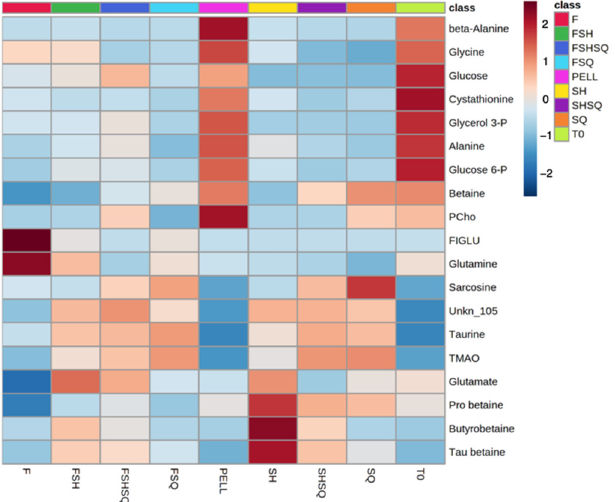
Figure 3. Heat map showing relative metabolite levels for the 19 most discriminating metabolites among the 8 diets (F, FSH, FSHSQ, FSQ, PELL, SH, SHSQ, SQ) and the conditioning diet (T0) measured in red drum liver extracts. A gradient color scale from red (high) to blue (low) indicates mean relative levels of the 19 most discriminating metabolites (rows) in the 9 diets (columns). F, fish diet; FSH, fish + shrimp diet; FSHSQ, fish + shrimp + squid diet; FSQ, fish + squid diet; PELL, pelleted commercial fishmeal-based diet; SH, shrimp diet; SHSQ, shrimp + squid diet; SQ, squid diet. Glycerol 3-P, glycerol 3-phosphate; glucose 6-P, glucose 6-phosphate; PCho, O-phosphocholine; FIGLU, N -formimino-L-glutamate; Pro betaine, proline-betaine; Tau betaine, taurine-betaine.